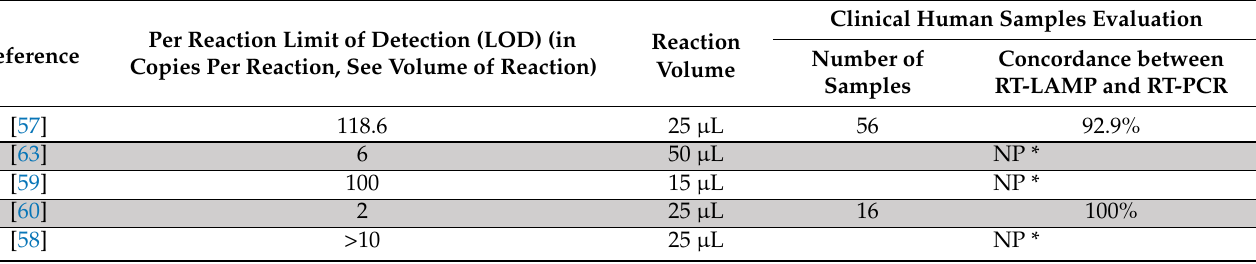
Table 3. Parameters of detection for the RT-LAMP reaction and its clinical evaluation.